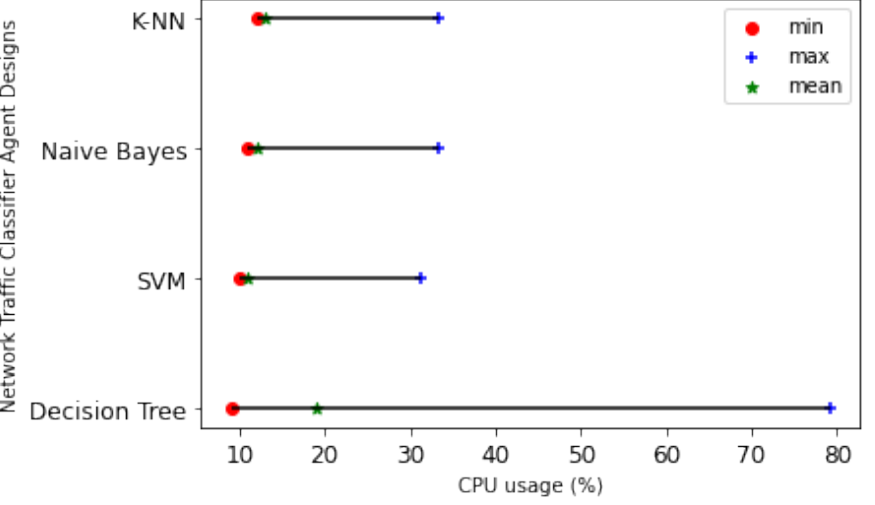
Figure 18. Comparison of NTCA CPU